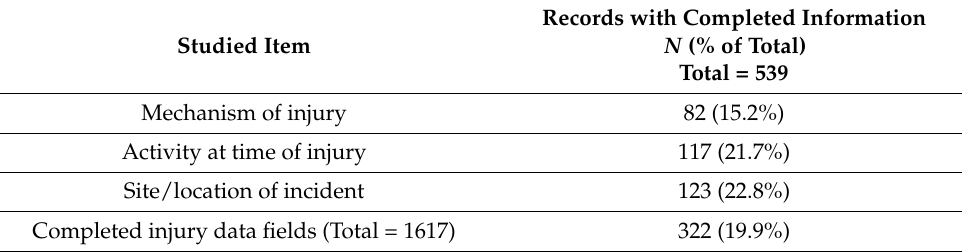
Table 4. Availability of data describing the injury incident in the medical records of trauma